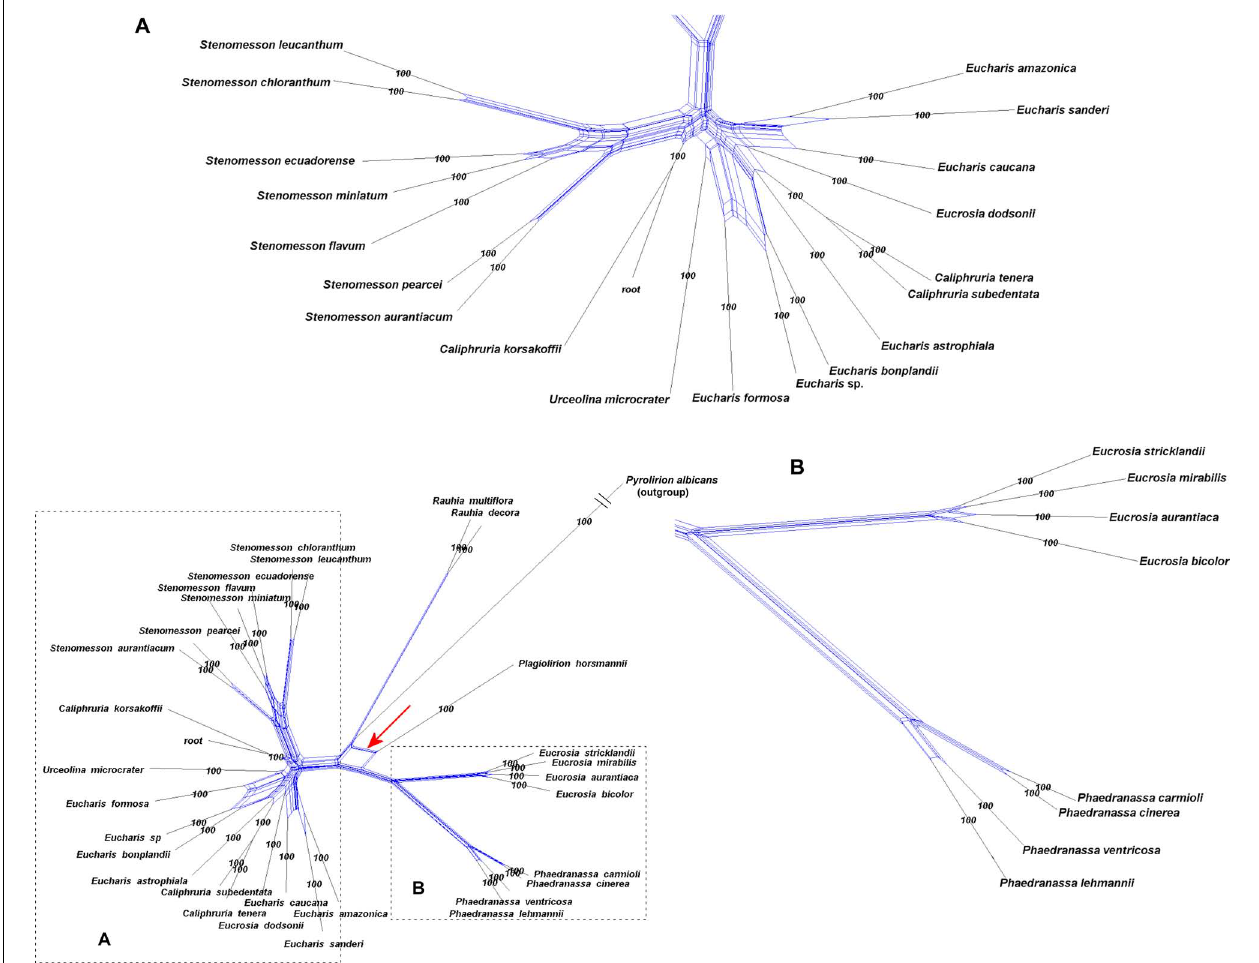
FIGURE 7 | Equal angle 360 ◦ hybridization network generated by SplitsTree v. 4.15.1 based on the 99% taxon coverage supermatrix (70 nuclear genes) across the tribe Eucharideae, with percentages from 300 bootstrap iterations. The entire network is shown in the inset, with subclades (A) and (B) magnified for clarity. Red arrow indicates possible reticulate origin of the monotypic Plagiolirion